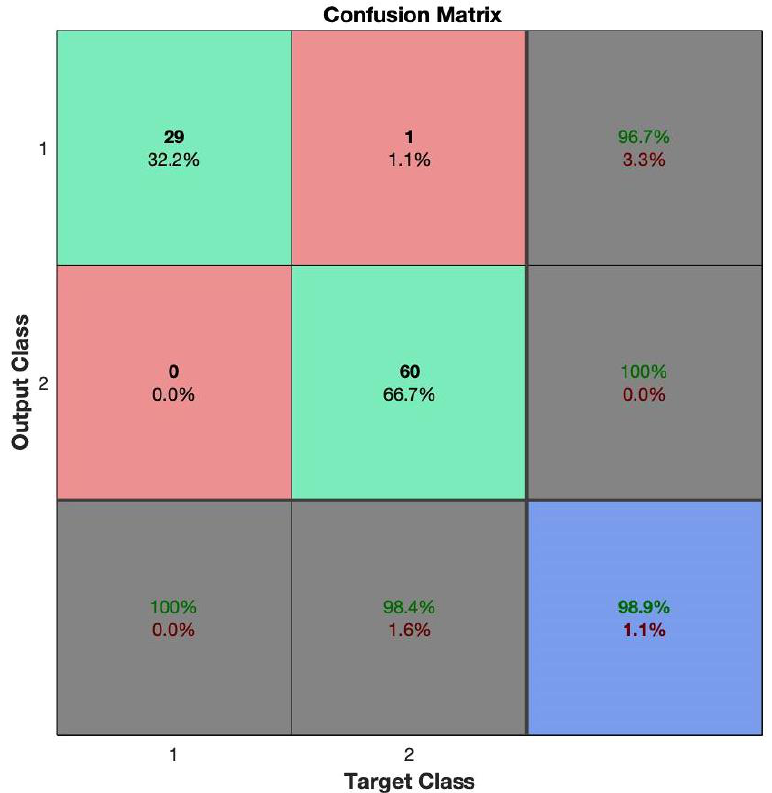
Figure 3. LEBoosting classification confusion